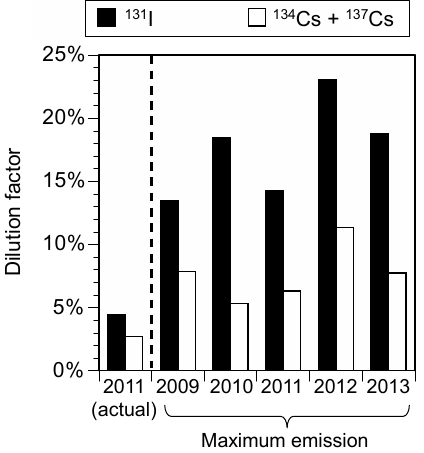
Figure 2. Dilution factors of radioiodine and radiocesium (men, ≥ 19 year).